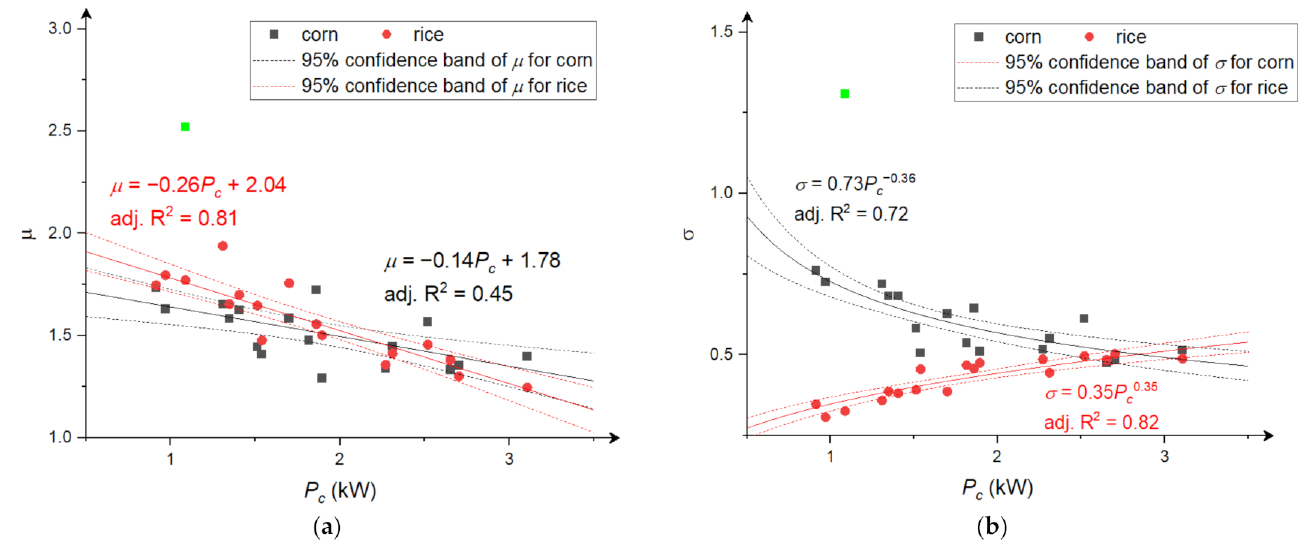
Figure A2. The dependence between µ (average value) and σ (variance) and power consumption during comminution; ( a ) µ (average value); ( b ) σ (variance). The green points are outliers not included in the analysis.